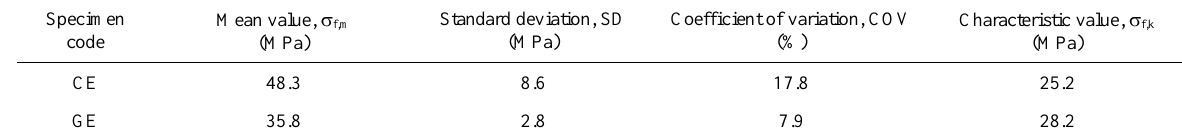
Table 3: Statistical assessment of the test